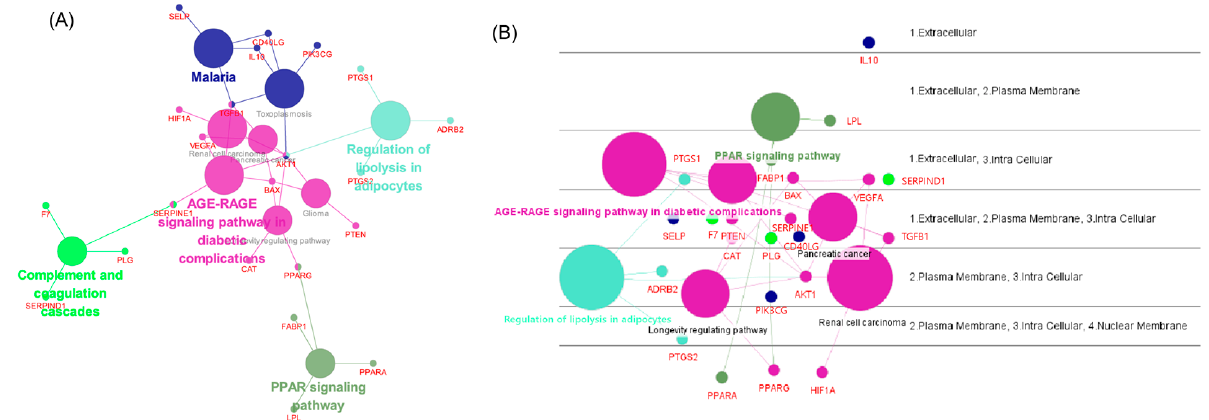
Figure 4. Visualization of the KEGG pathways and targets of the herbal combination analyzed by ClueGO and CluePedia. ( A ) Visualization of significantly enriched KEGG pathways and their genes (created with ClueGO) ( B ) Cerebral layout of significant KEGG pathways and their genes by their cellular compartment (created with CluePedia).